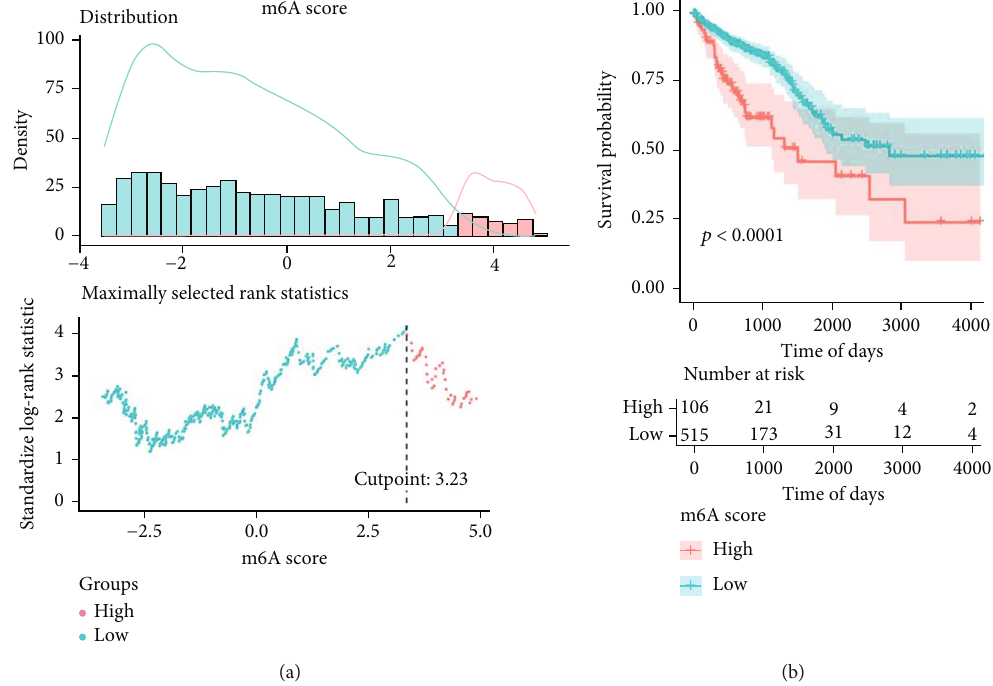
Figure 5: The optimal gradient for the m6Ascore (m6Ascore) among di ff erent clinical groups. (a) Correlation between density statistics of m6Ascore distribution and the determination of optimal threshold. (b) Survival curves between high- and low-m6Ascore